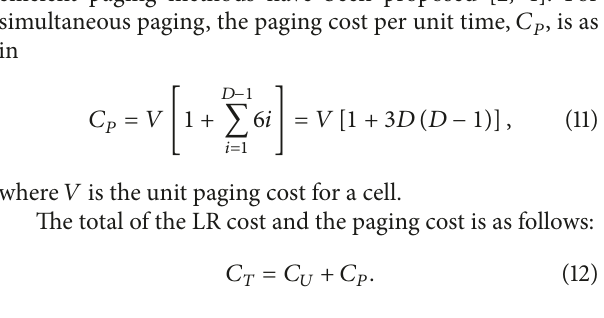
Figure 5: Registration cost and its difference ratio ( 𝑇 𝑚 ∼ Gam- ma(1/2,